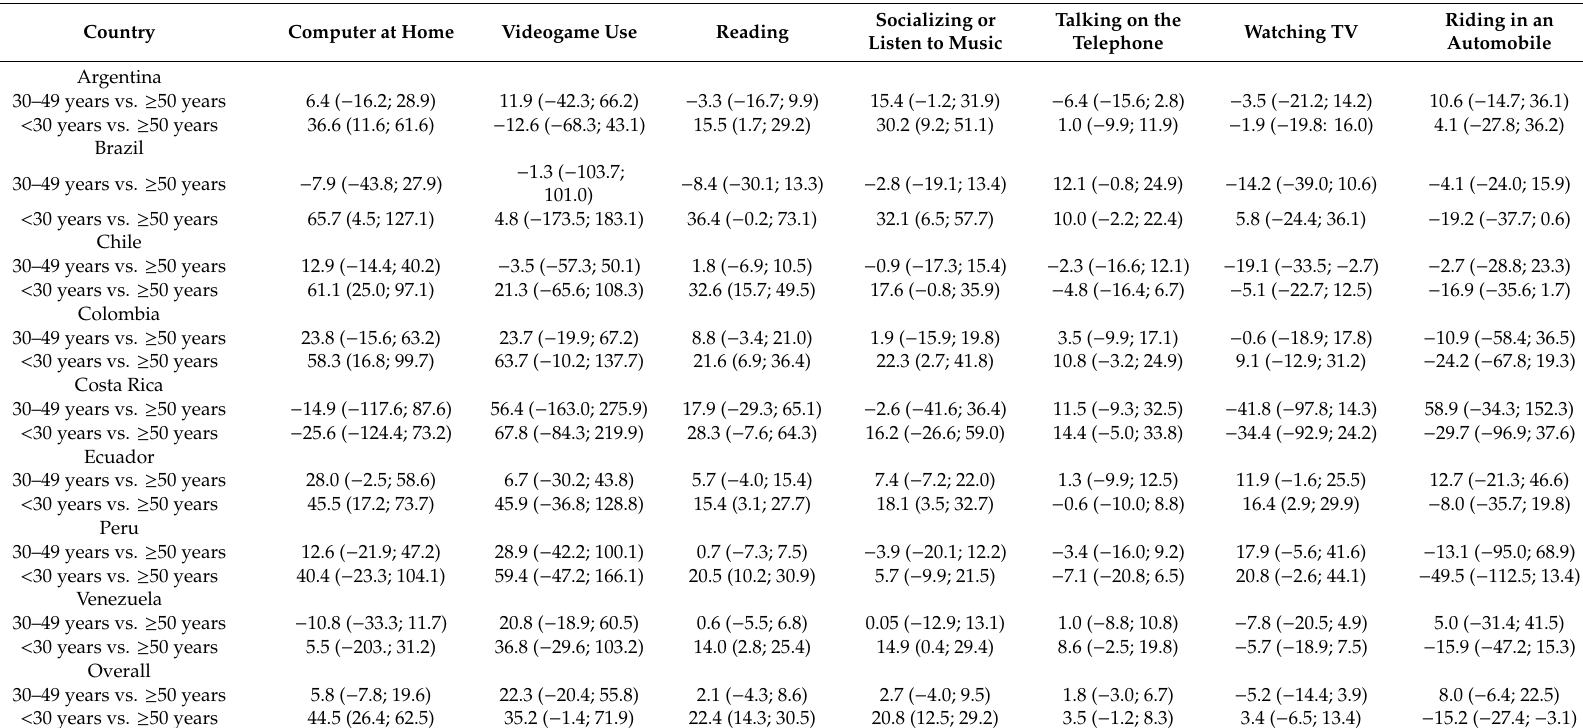
Socializing or Talking on the Riding in an Watching TV Listen to Music Telephone Automobile